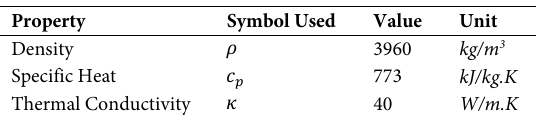
Table 2. Properties of the nanofluid